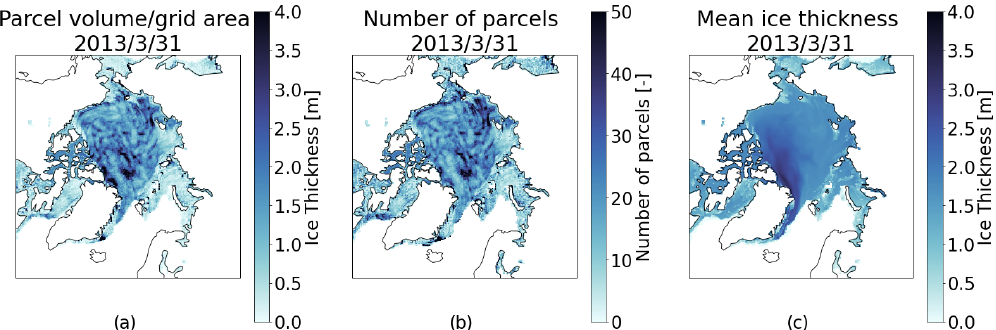
Figure A1. SLICE parcels on 31 March 2013: (a) regridded using total parcel volume per grid cell divided by grid area, (b) counts within grid cell, and (c) regridded mean parcel thickness within each grid cell. The volume per grid cell approach is unrealistic and dominated by erroneous convergence and divergence of parcels within grid cells.